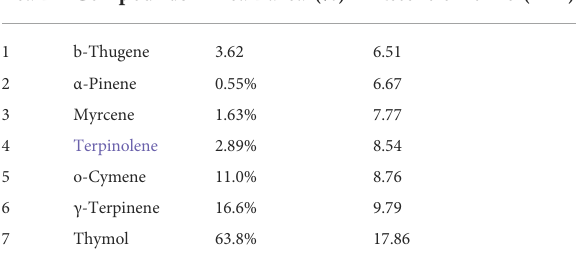
TABLE 1 Composition of Monarda didymaL. essential